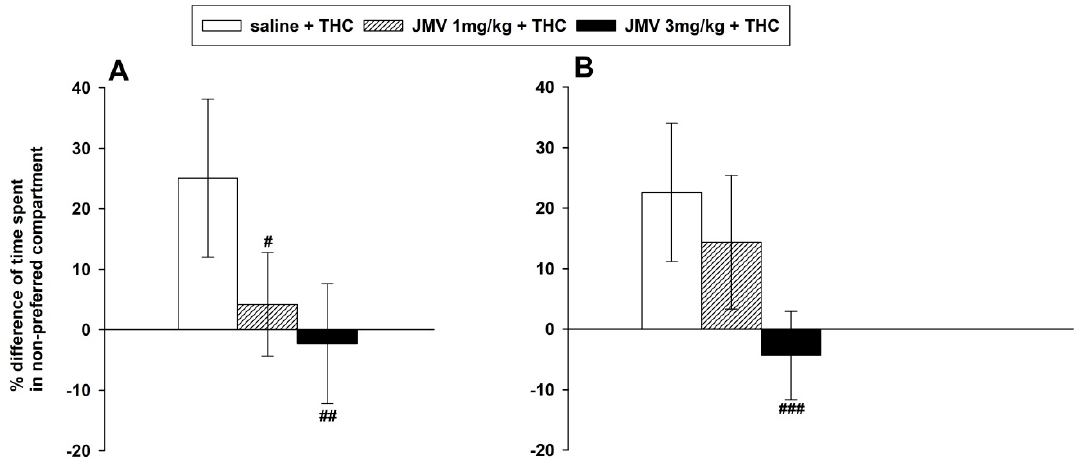
Figure 1. Effects of JMV2959 on tetrahydrocannabinol (THC)-induced conditioned place preference (CPP) in rats. In graph ( A ), JMV2959 (0, 1, 3 mg/kg i.p.) was administered in a single dose 20 min before the final testing after 8 days of condi-